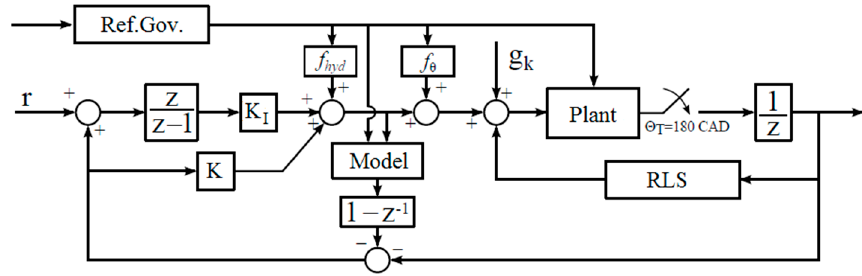
Figure 30. A hydraulic, free-piston engine feedback control block diagram [54].